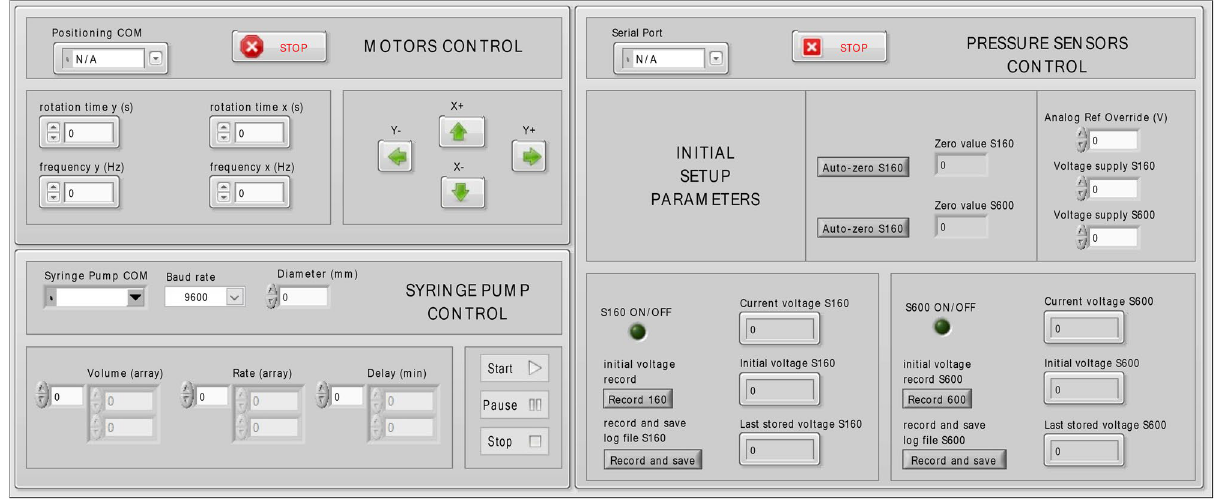
Figure 15. LABVIEW interface to control the micropipette